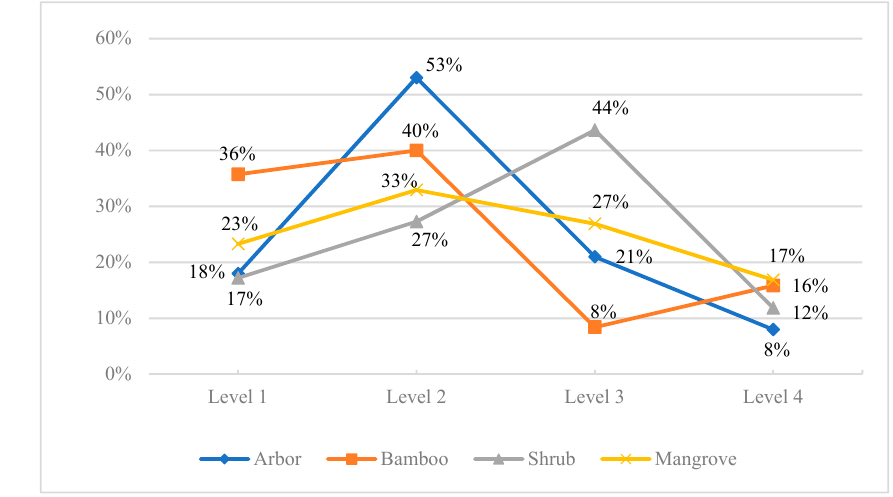
Figure 4. Percentage distribution of FLQ levels for arbor, bamboo, shrub and mangrove forest.